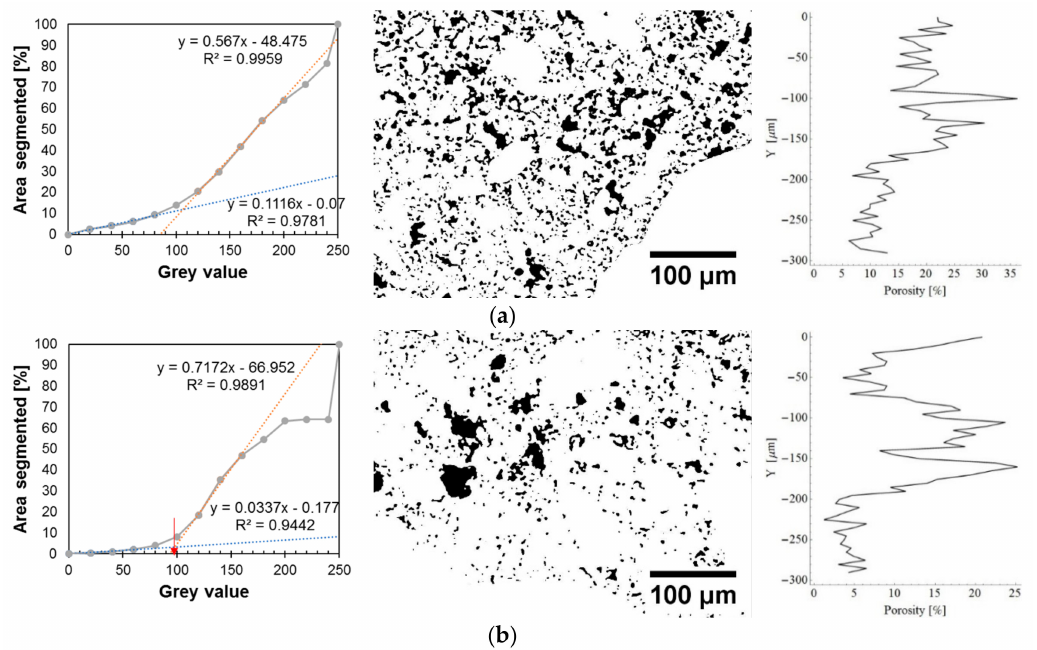
Figure 14. Exemplary cumulative gray scale histograms, images of segmented pores and charts of the fractional share of pores along the thickness within the subsurface zone for the mortar: ( a ) without Al 2 O 3 nanopowder; ( b ) modified with the addition of 0.5% of Al 2 O 3